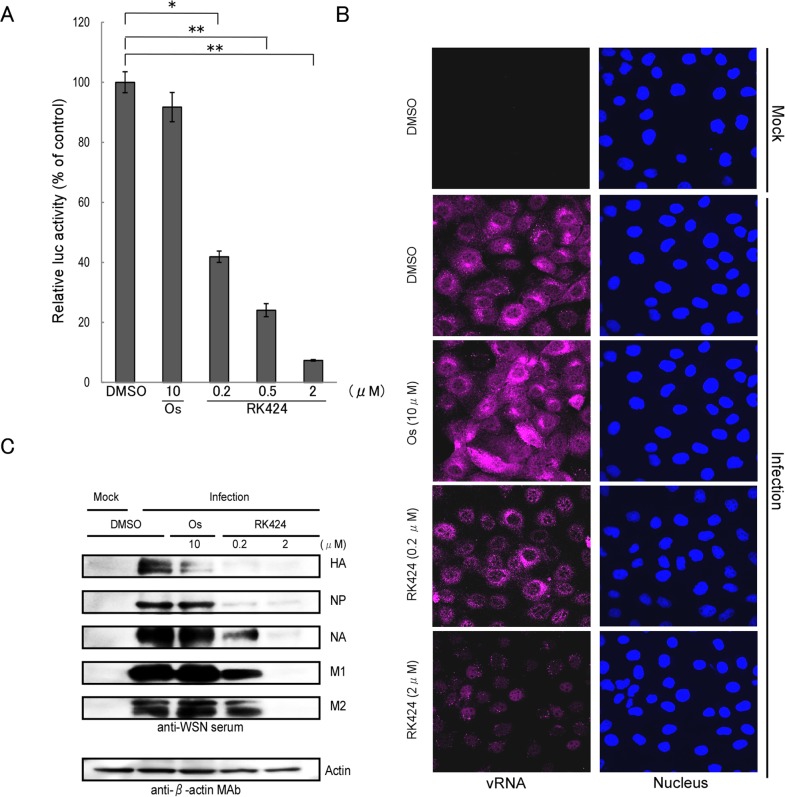
Effect of RK424 on viral transcription, replication, and translation.(A) HEK293T cells were transfected with pCAGGS expression plasmids encoding PB2, PB1, PA, NP, and vNP-luc in the absence or presence of RK424 (0.2, 0.5, and 2 μM). The effect of vRNA transcription was then evaluated by measuring luciferase activity at 48 h post-transfection. Data are expressed as the mean ± SD of three samples in each of three independent experiments. *;p<0.005 and **;p<0.001. (B) MDCK cells were infected with A/WSN/1933 (H1N1) at an MOI of 5 in the absence or presence of RK424 (0.2 and 2 μM) and then fixed at 6 h post-infection. The cells were probed with Quasar 670-labeled probes against the PB2 segment (magenta) and nuclei were stained with Hoechst (blue). Two independent experiments were performed and one representative result is shown. (C) Virus-infected cells were treated with RK424 (0.2 μM and 2 μM) for 18 h and the cell lysates subjected to western blotting with anti-WSN virus serum and an anti-β-actin monoclonal antibody (MAb). Bands representing HA, NP, NA, M1, M2, and actin are indicated. Oseltamivir phosphate (Os) was used as the negative control. Two independent experiments were performed and one representative result is shown.